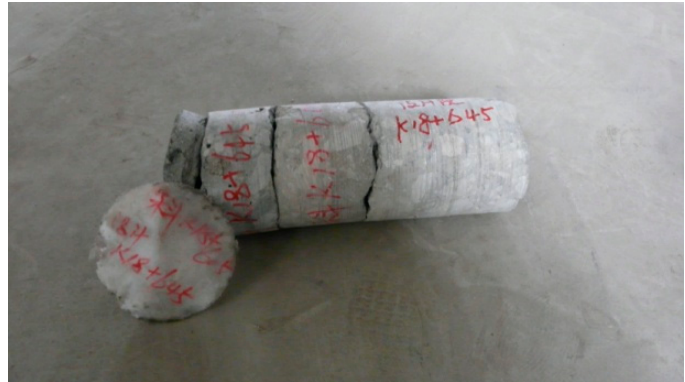
Figure 6. Core sample and waterproof board of right wall.